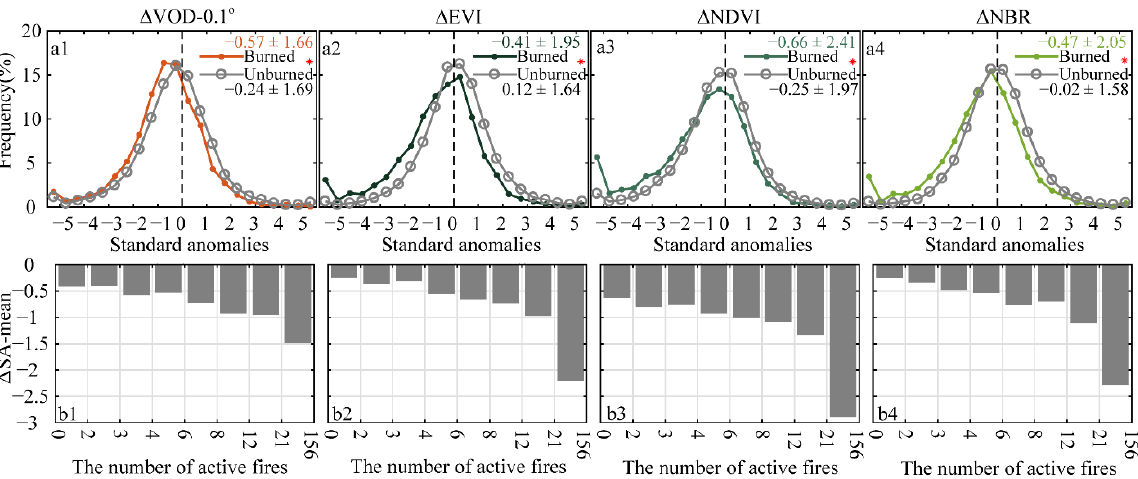
Figure 7. The comparison of ΔVM (ΔVM = VM Oct ‒ VM Jul ) standardized anomalies’ distribution between burned and unburned areas. Histograms of standardized anomalies in ( a1 ) ΔVOD-0.1°; ( a2 ) ΔEVI; ( a3 ) ΔNDVI; and ( a4 ) ΔNBR. A red asterisk indicated that the anomalies between burned and unburned pixels were significantly different. The mean of standard anomalies of ( b1 ) ΔVOD-0.21°; ( b2 ) ΔEVI; ( b3 ) ΔNDVI; and ( b4 ) ΔNBR at different fire event levels.